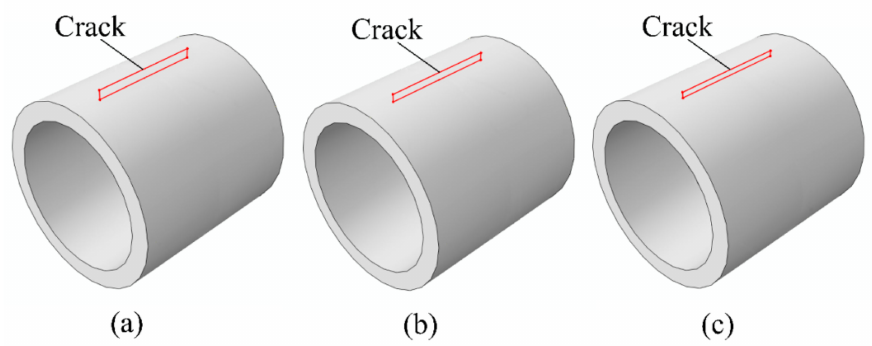
Figure 18. Pipes containing cracks with di ff erent depths: ( a ) 25 mm, ( b ) 20 mm, and ( c ) 15